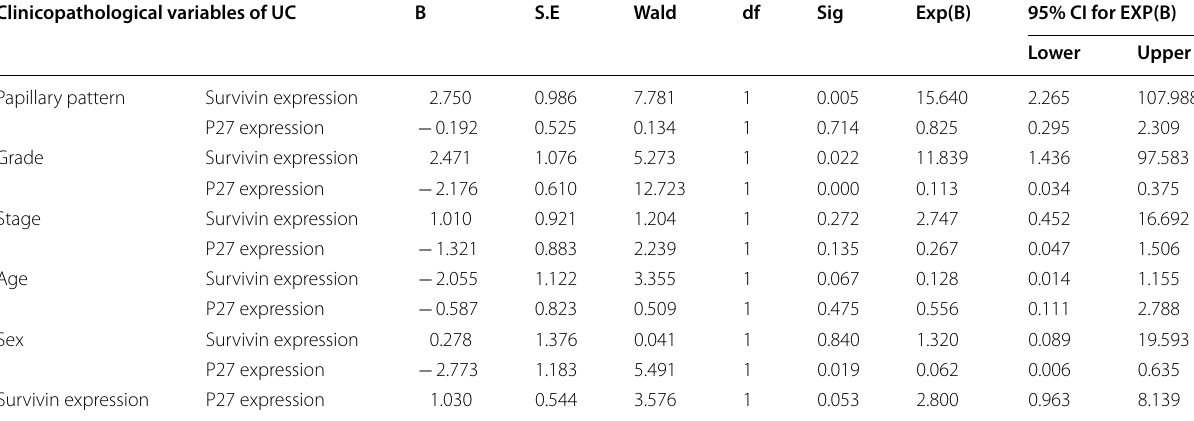
UC Urothelial carcinomas; B Coefficient of regression; SE Standard error; Wald, statistic of Wald test coefficient; df Degree of freedom; Sig P -value; Exp(B), odds ratio; 95% CI, 95% confidence interval